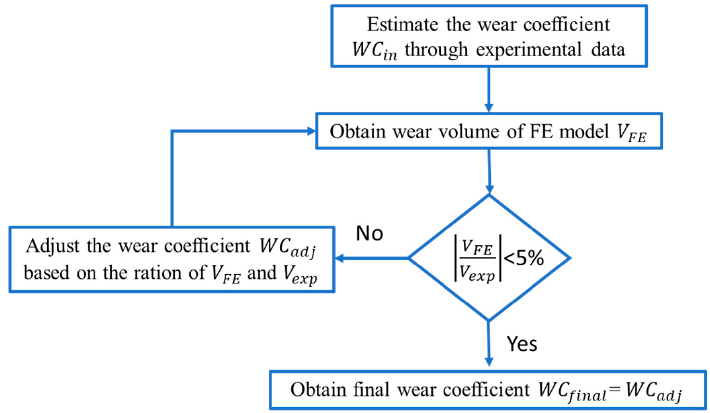
Figure 9 are shown in Figure 11.